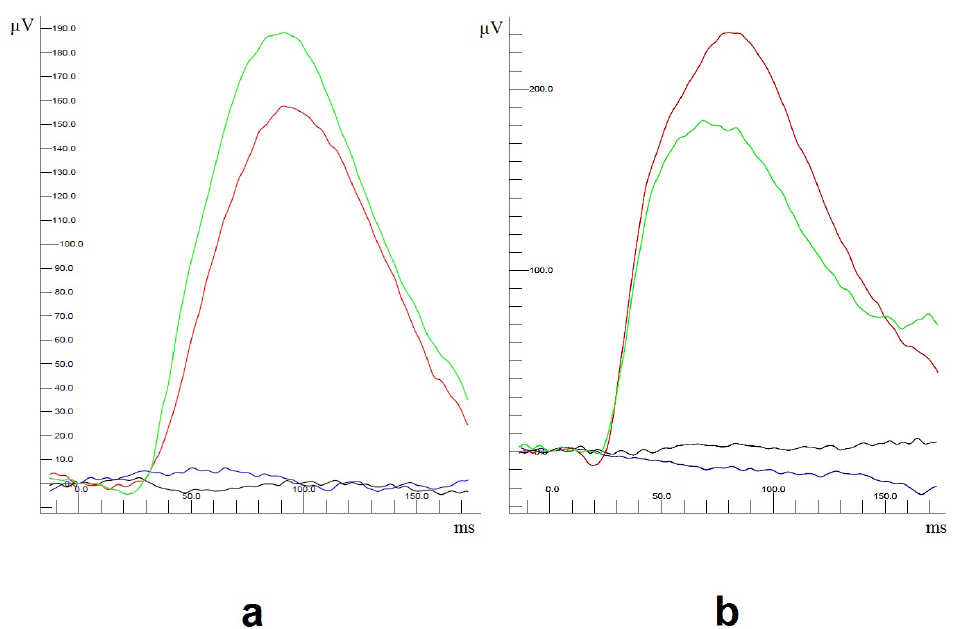
Figure 2. Curve of the horses ERG, translating the electrical activity of rod photoreceptors ( µ V) and implicit time (ms). Case 1 represented by graph ( a) and case 2 by graph ( b) . The blue and black lines represent, respectively, activities in the right and left eyes of animals with night blindness. The green and red lines represent, respectively, activities in the right and left eyes of normal